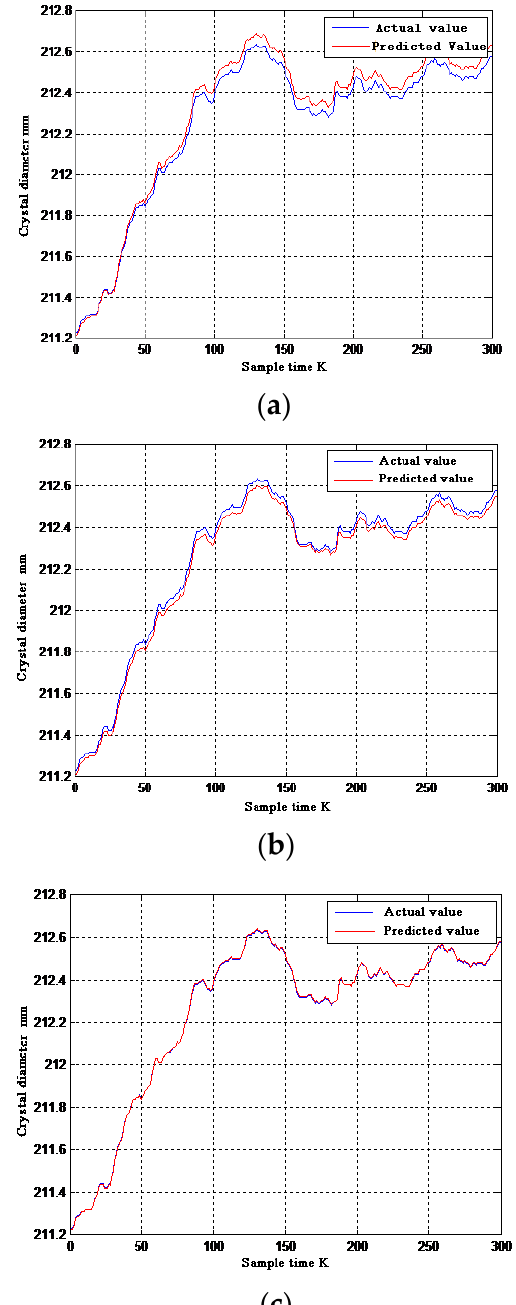
Figure 10. Experiment results: crystal diameter curves of measured and predicted value: ( a ) SVR, ( b ) BPNN, and ( c ) CRBM-DBN-SVR.